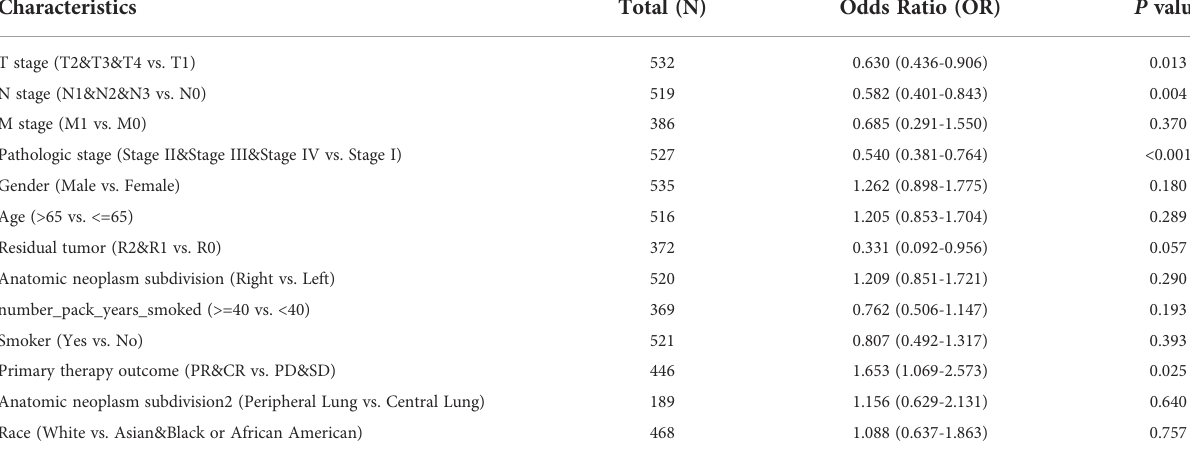
TABLE 2 Logistic analysis of the correlation between MDFI expression and clinical characteristics.